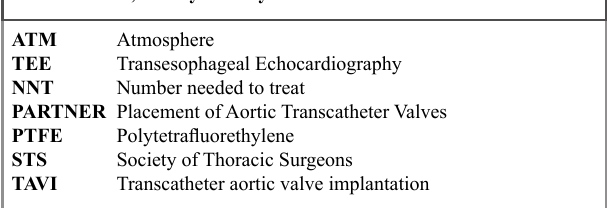
Objetivo: O presente trabalho tem por objetivo demonstrar pela via transfemoral ou